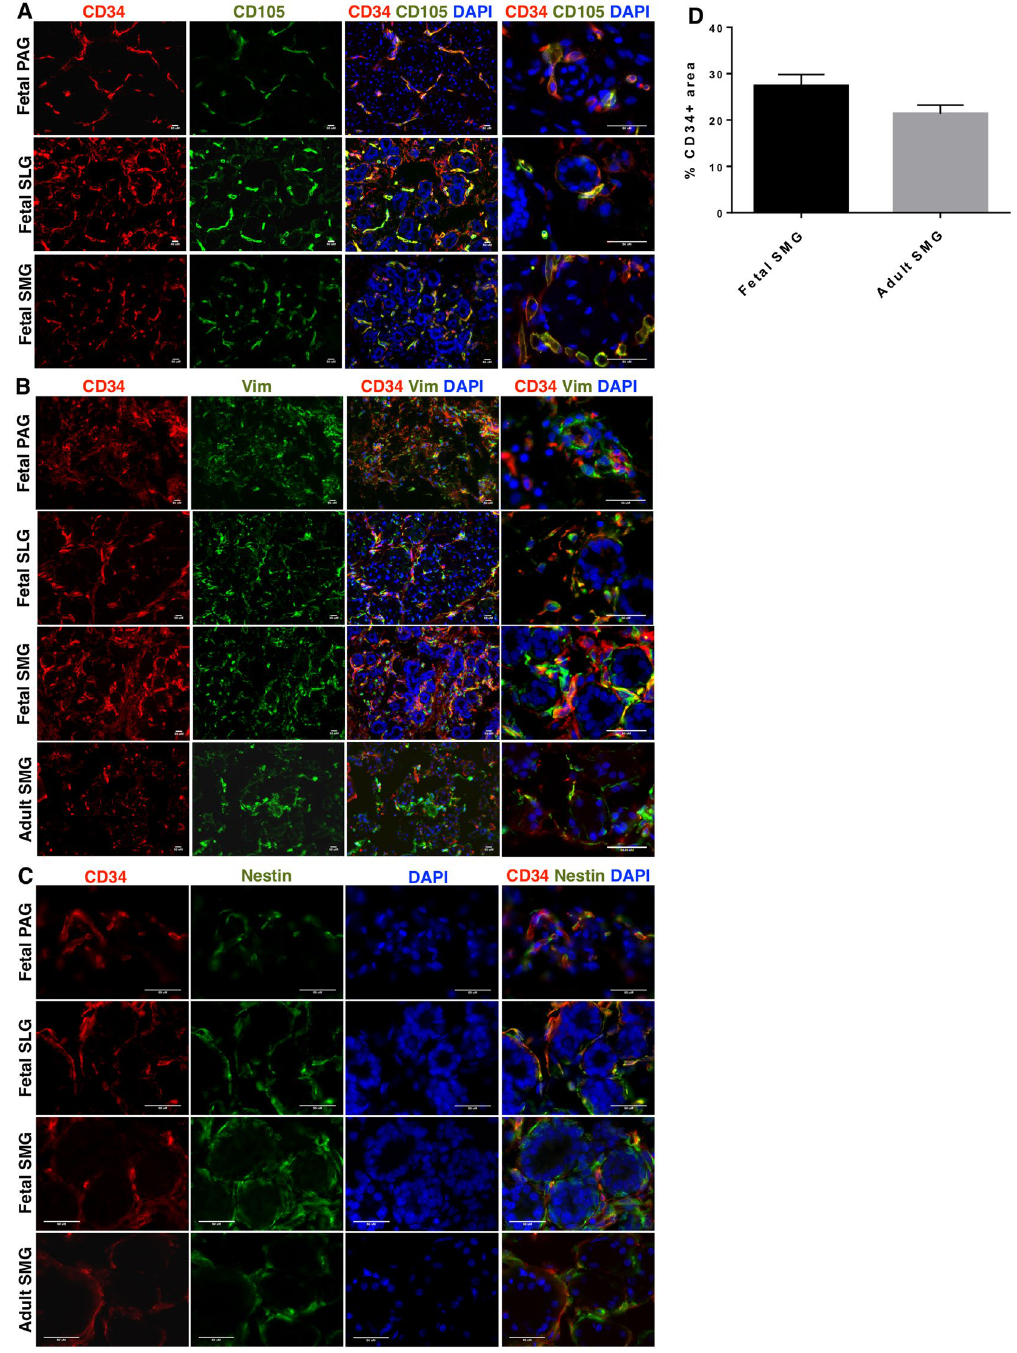
Figure 2. In situ localization of ( A ) CD34 (red) and CD105 (green) in fetal SGs ( B ) CD34 (red) and vimentin (vim) (green) ( C ) CD34 (red) and nestin (green) in fetal SGs and adult SMGs. All scale bars represent 50 µ M. ( D ) Quantitative differences in the expression of CD34 between fetal and adult SMGs. Error bars represent mean ±